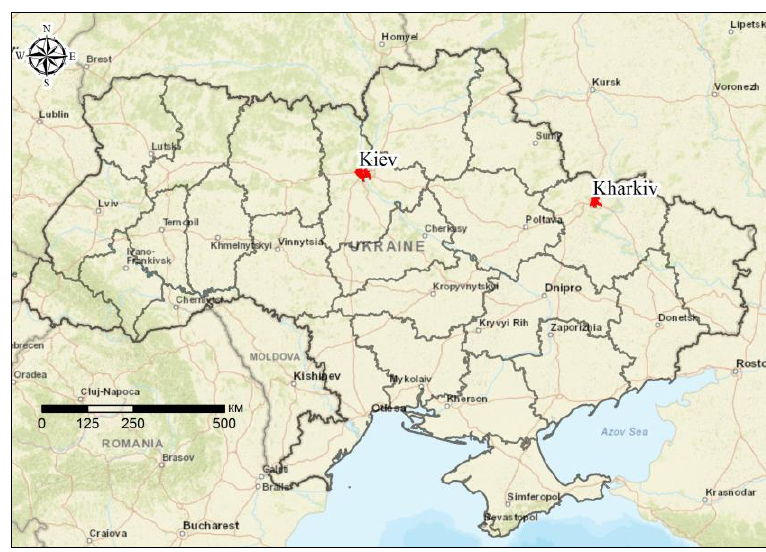
Fig. 1. Map of Ukraine showing the boundary of the study area (source: author’s own